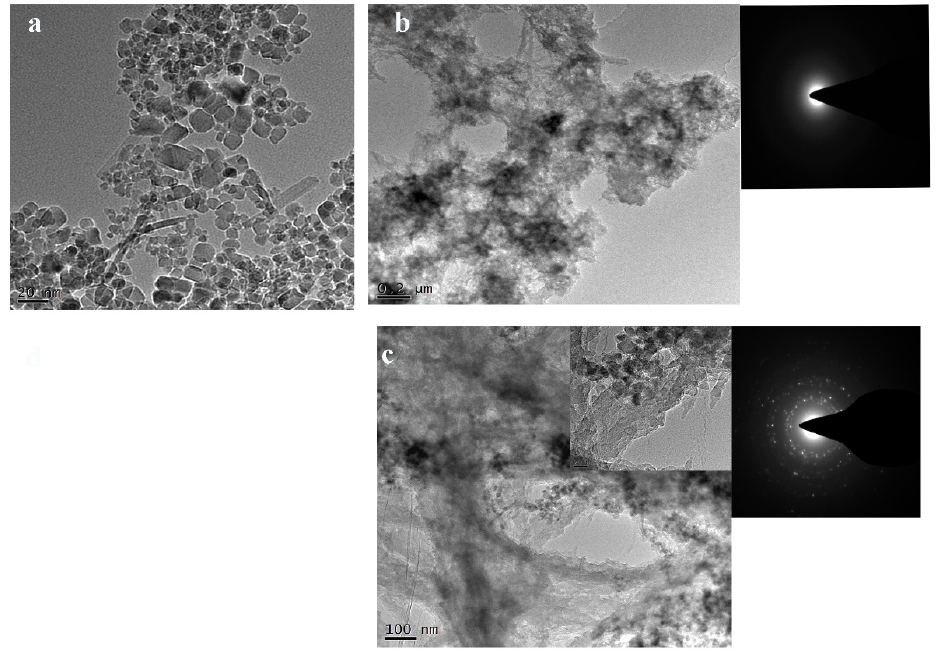
Figure 2. TEM (transmission electron microscopy) and electron diffraction patterns of ( a ) Fe 3 O 4 ; ( b ) P p PD; and ( c ) P p PD/Fe 3 O 4 .